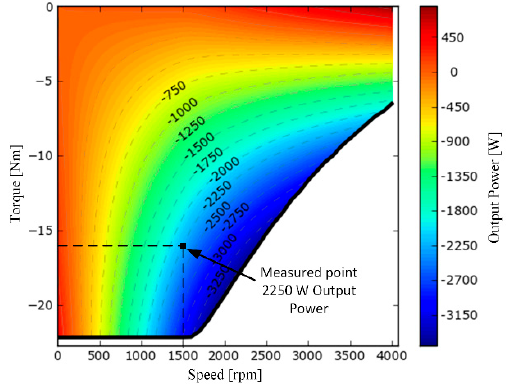
Figure 10. E ffi ciency and reactive power ratio measurements at 1500 Figure 10. Efficiency and reactive power ratio measurements at 1500 rpm.